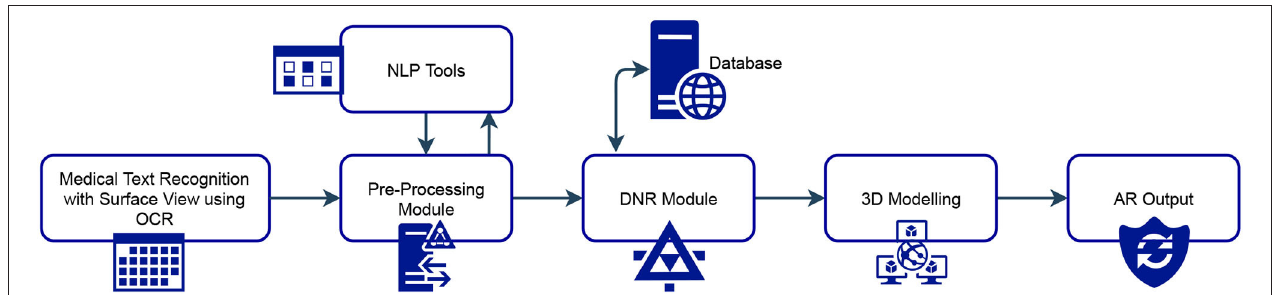
FIGURE 2 | Proposed system